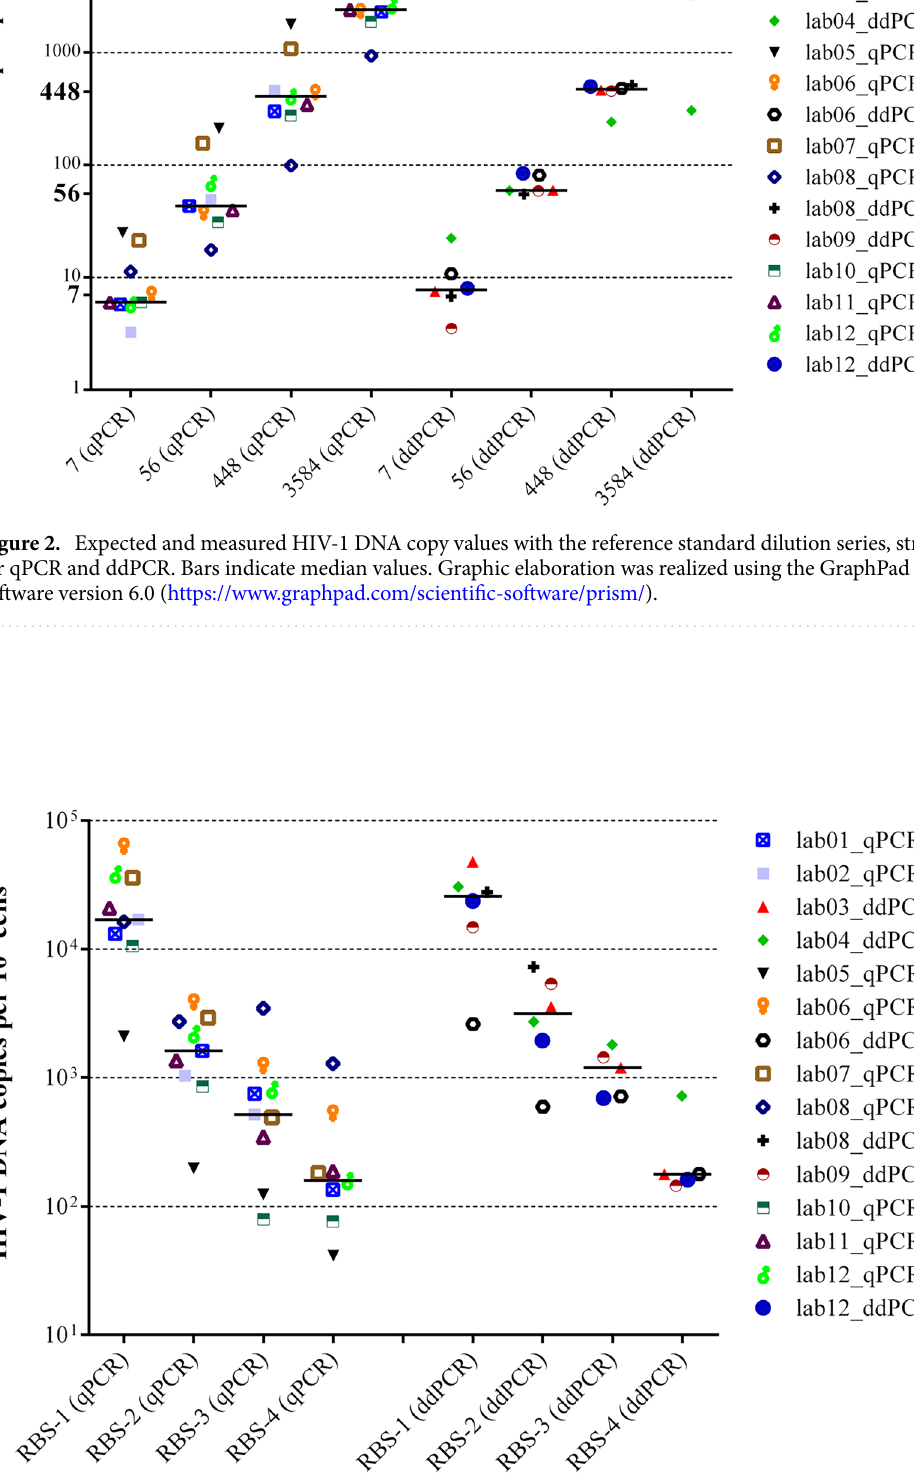
Figure 3. HIV-1 DNA (copies per 10 6 cells) measured by the participating laboratories in the different reconstructed blood samples (RBS), stratified for qPCR and ddPCR. Bars indicate median values. Graphic elaboration was realized using the GraphPad Prism software version 6.0 (https:// www. graph pad. com/ scien tific- softw are/